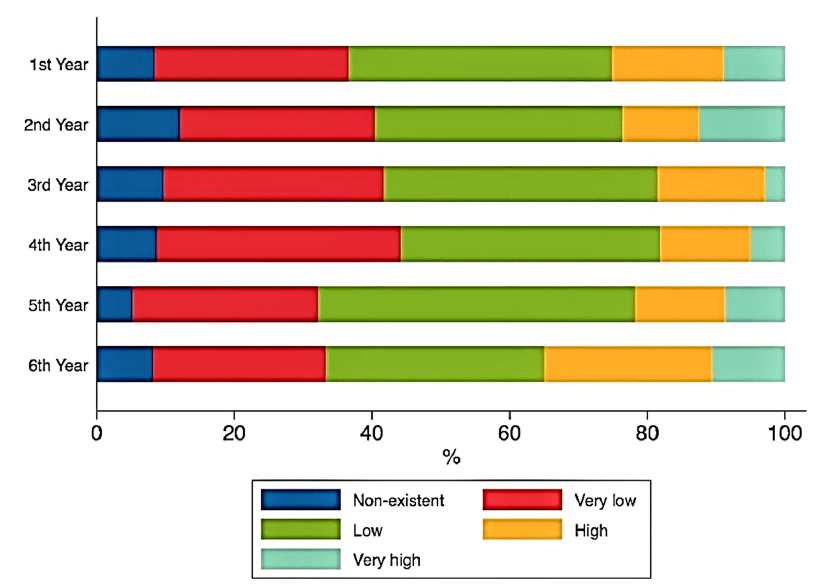
Figure 1. Academic online learning.